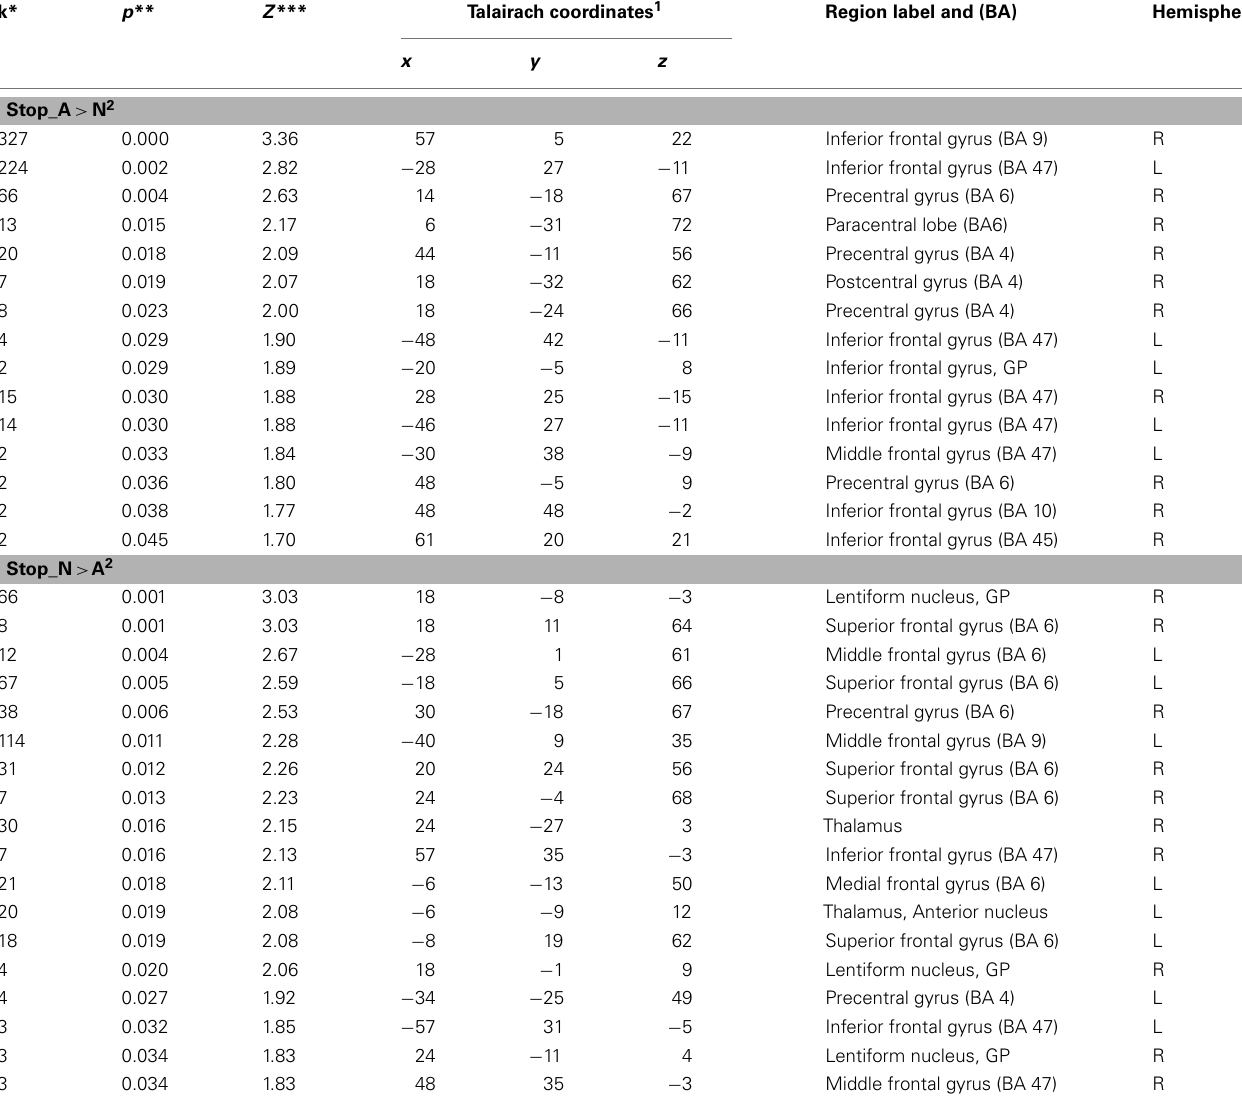
Table 7 | Differential activation between conditions during correct inhibited